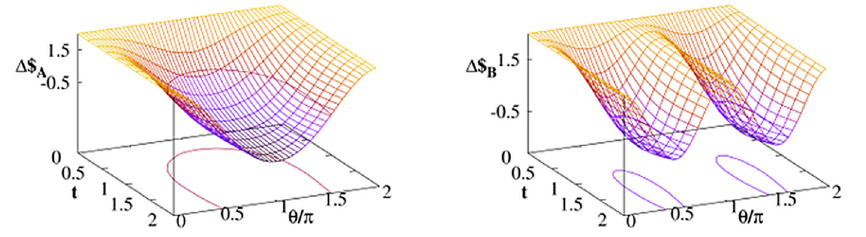
Fig 2. The same as in Fig (1) but for Alice – Bob strategy profile ( I , F U